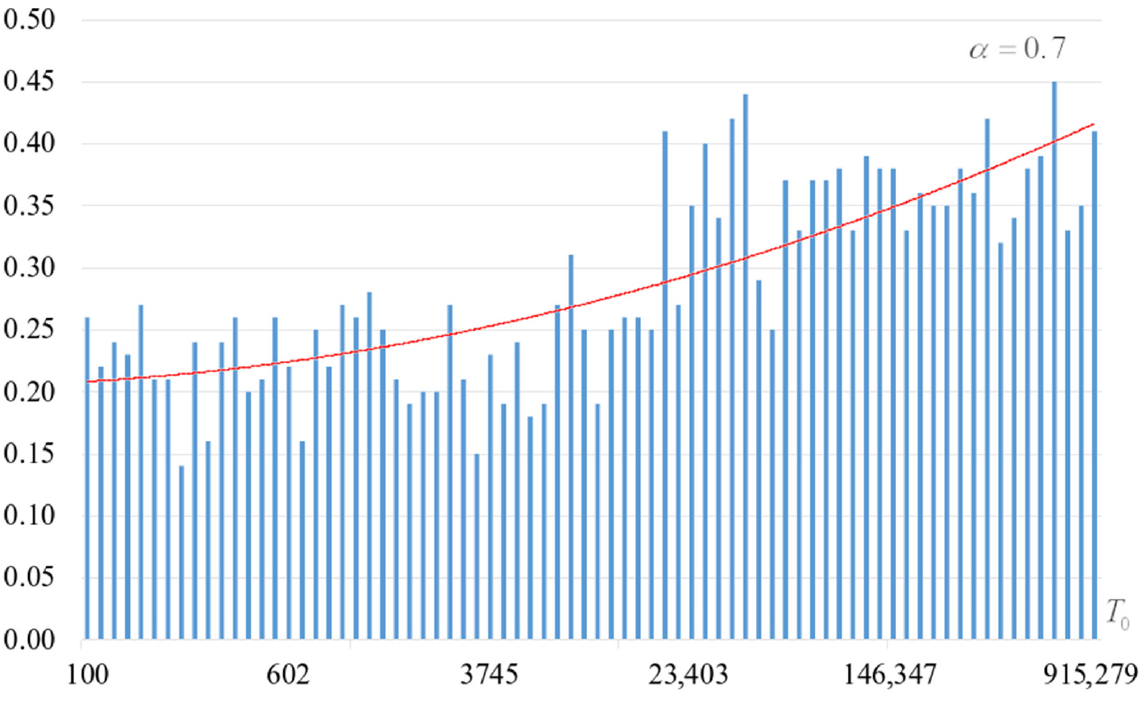
Figure 3. The probability of forming the target S-box at 0.7